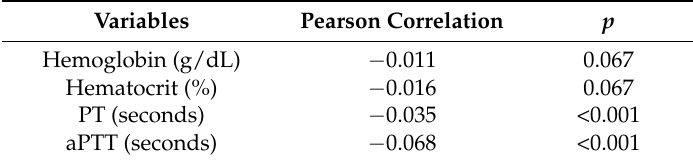
analysis (Table 5) revealed that patients being male, with older age, pre-existed CHF and ESRD, low body temperature, and with a higher injury severity were significantly associated with the mortality